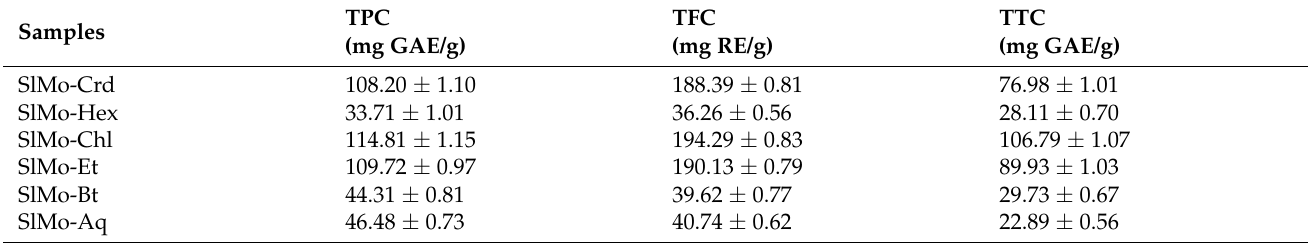
Table 1. Quantitative phytochemical analysis of S. moorcroftiana